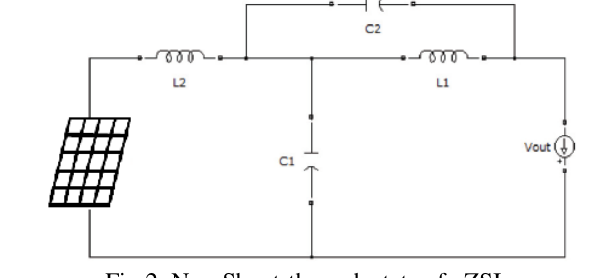
Fig.2: Non-Shoot-through state of qZSI In non-shoot through state, the power is delivered from PV source to grid. During the shoot through state, the power delivered to the load will be zero. During this time period, the impedance network involves in boosting the input voltage [7].